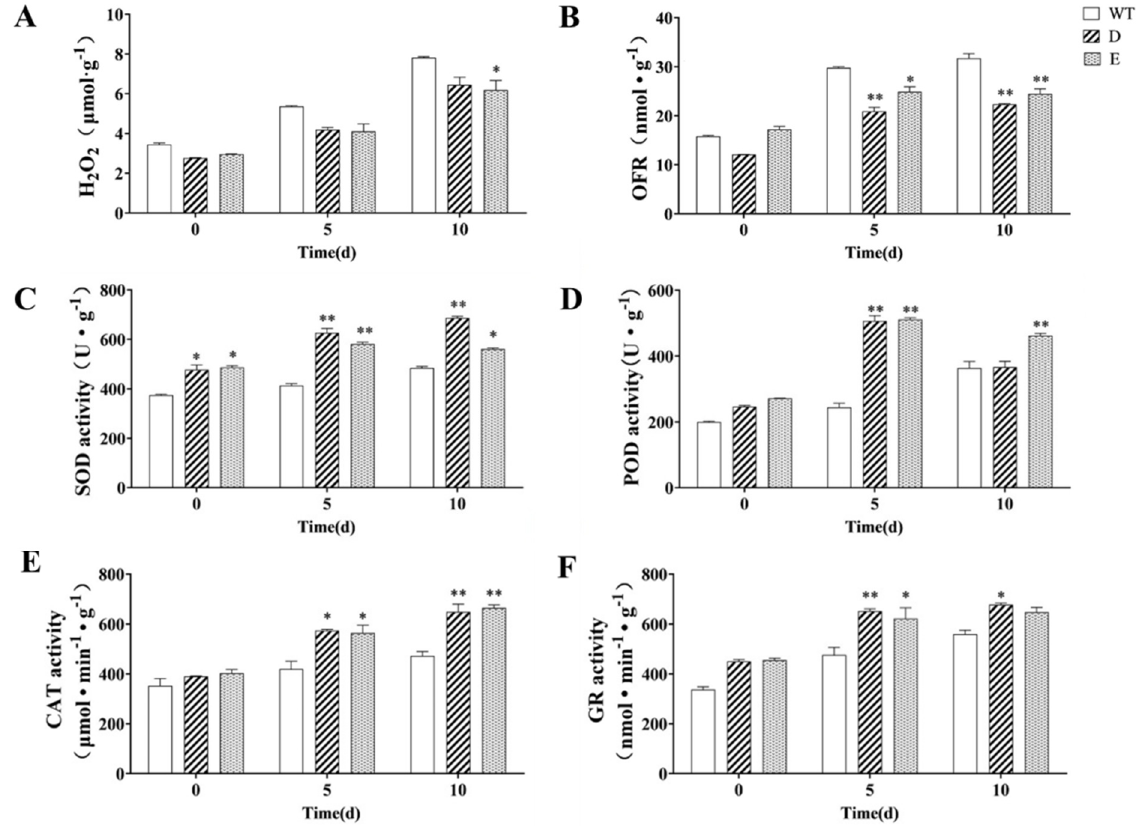
Figure 5. Changes in the antioxidant capacity of MsRCI2D/-E transgenic alfalfa hairy roots before and after exposure to salt stress. Comparison of H 2 O 2 and ORF contents ( A , B ), SOD activity ( C ), POD activity ( D ), CAT activity ( E ), and GR ( F ) in WT plants and transgenic alfalfa hairy roots before and after 5 and 10 days of salt treatment. The values are the means ± SDs of three replicates; * indicates a significant difference ( p < 0.05); ** indicates an extremely significant difference ( p < 0.01).